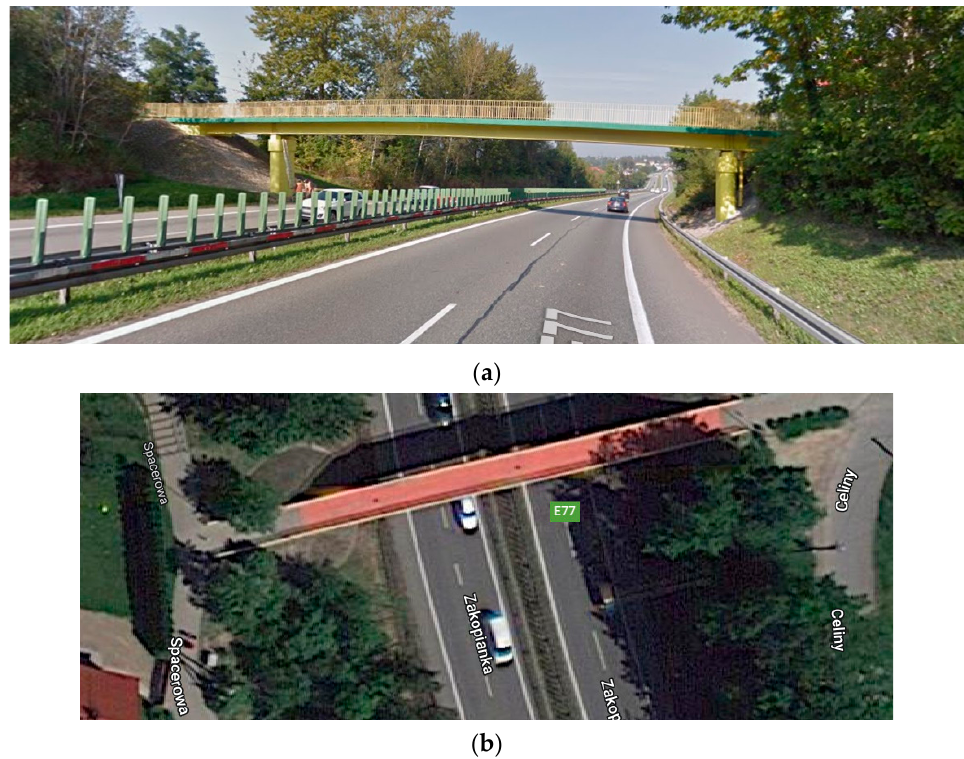
Figure 1. ( a ) General view of the analyzed footbridge, ( b ) location of the structure (source: google.com/maps/place/Celiny,+32-031+Mogilany/@49.9441301,19.891348,86m/data=!3m1!1e3!4m5!3m4!1s0x471667e327866d15:0x2be86a9c42b5bf72!8m2!3d49.9452772!4d19.8960001 (accessed on 12 December 2022)).